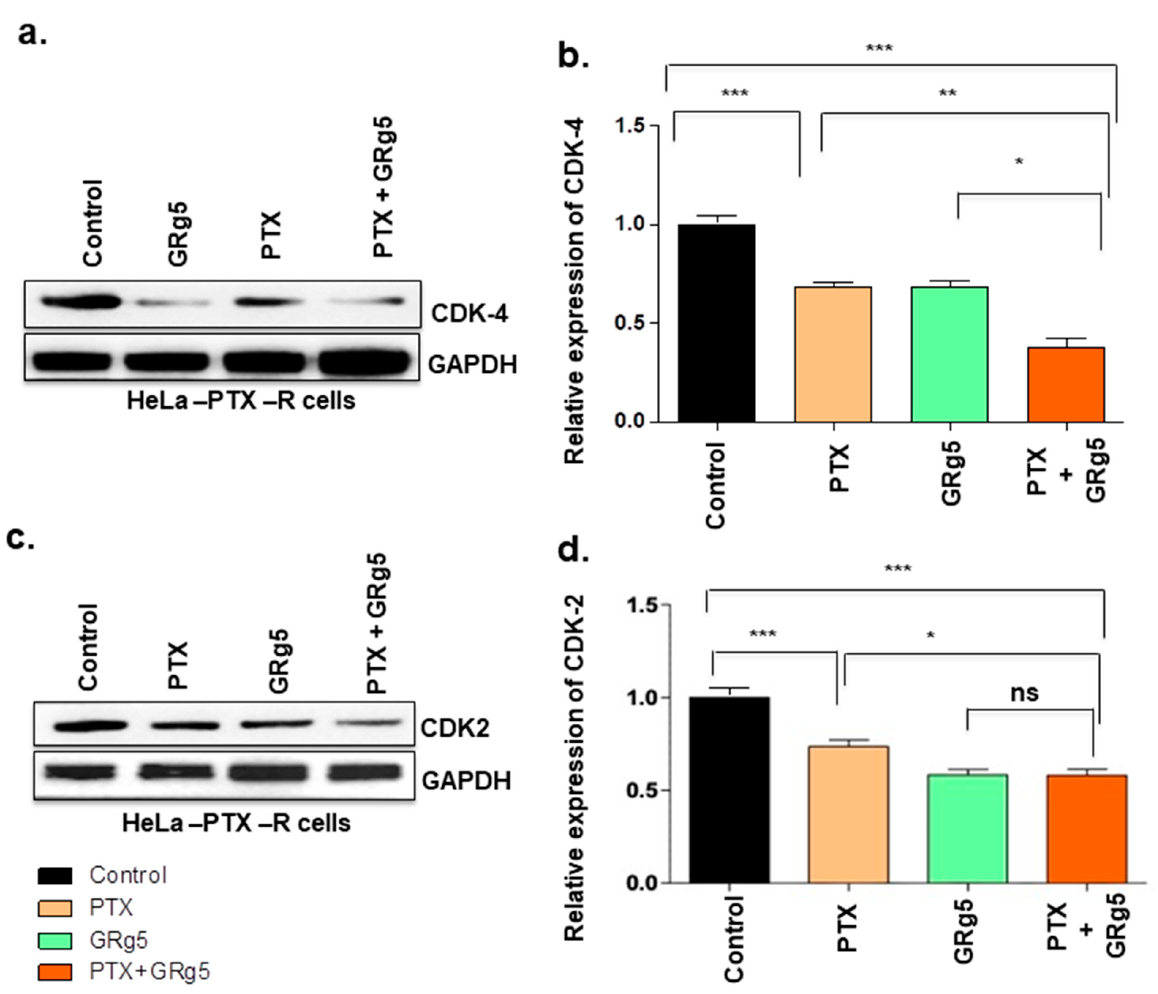
Figure 10. Quantitative analysis of cell cycle regulatory CDK proteins expression levels using Western Blot: HeLa-PTX-R cells, treated with GRg5 alone, PTX alone or in combination with GRg5 (20 µ M) + PTX (4 nM) for 48 h, were investigated. The figures represent Western blot of ( a ) CDK4, and ( c ) CDK2 proteins. The graph plot ( b , d ) represents the quantitative analysis of the blots. Data is represented as mean ± S.E.M of three individual observations. Statistical significance was assessed using One way-ANOVA and Tukey’s post hoc test. ***, p < 0.001; **, p < 0.01; *, p ≤ 0.05; ns, non-significant.